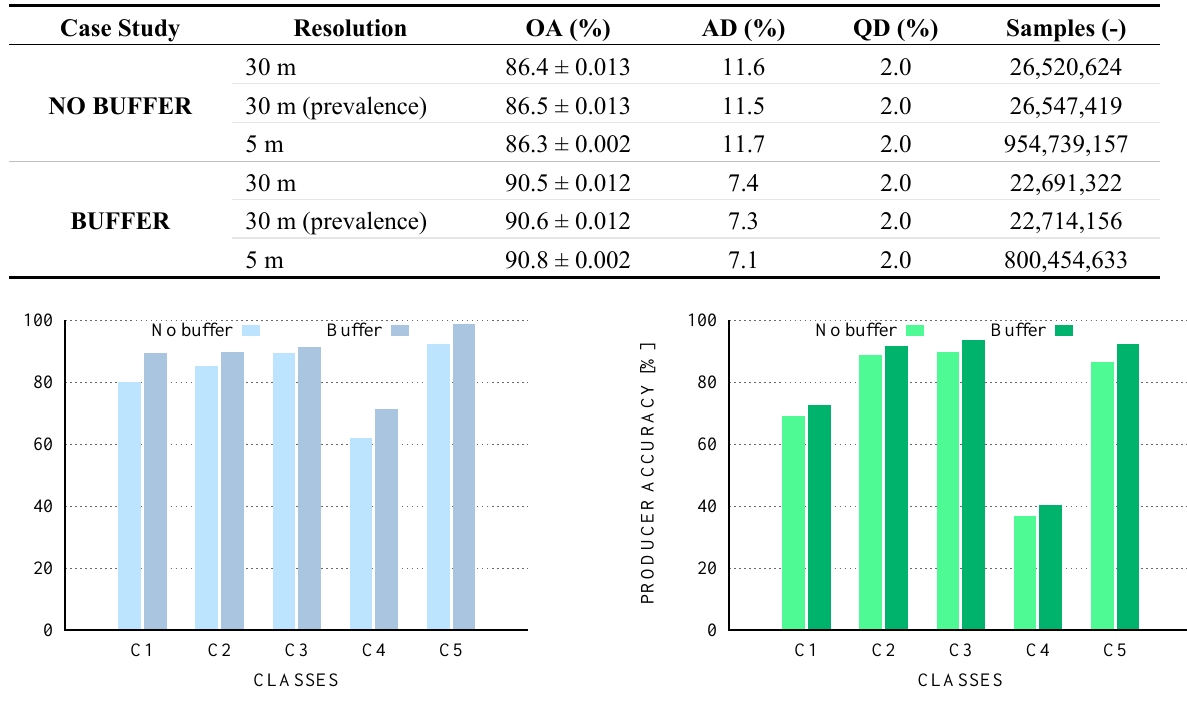
Table 4. Comparison between GlobeLand30 2000 and DUSAF1.1 (I reclassification): overall statistics and number of samples for the two cases of no buffer and buffer and for different resolutions. OA: overall accuracy (confidence intervals at 95% probability); AD: allocation disagreement; QD: quantity disagreement.